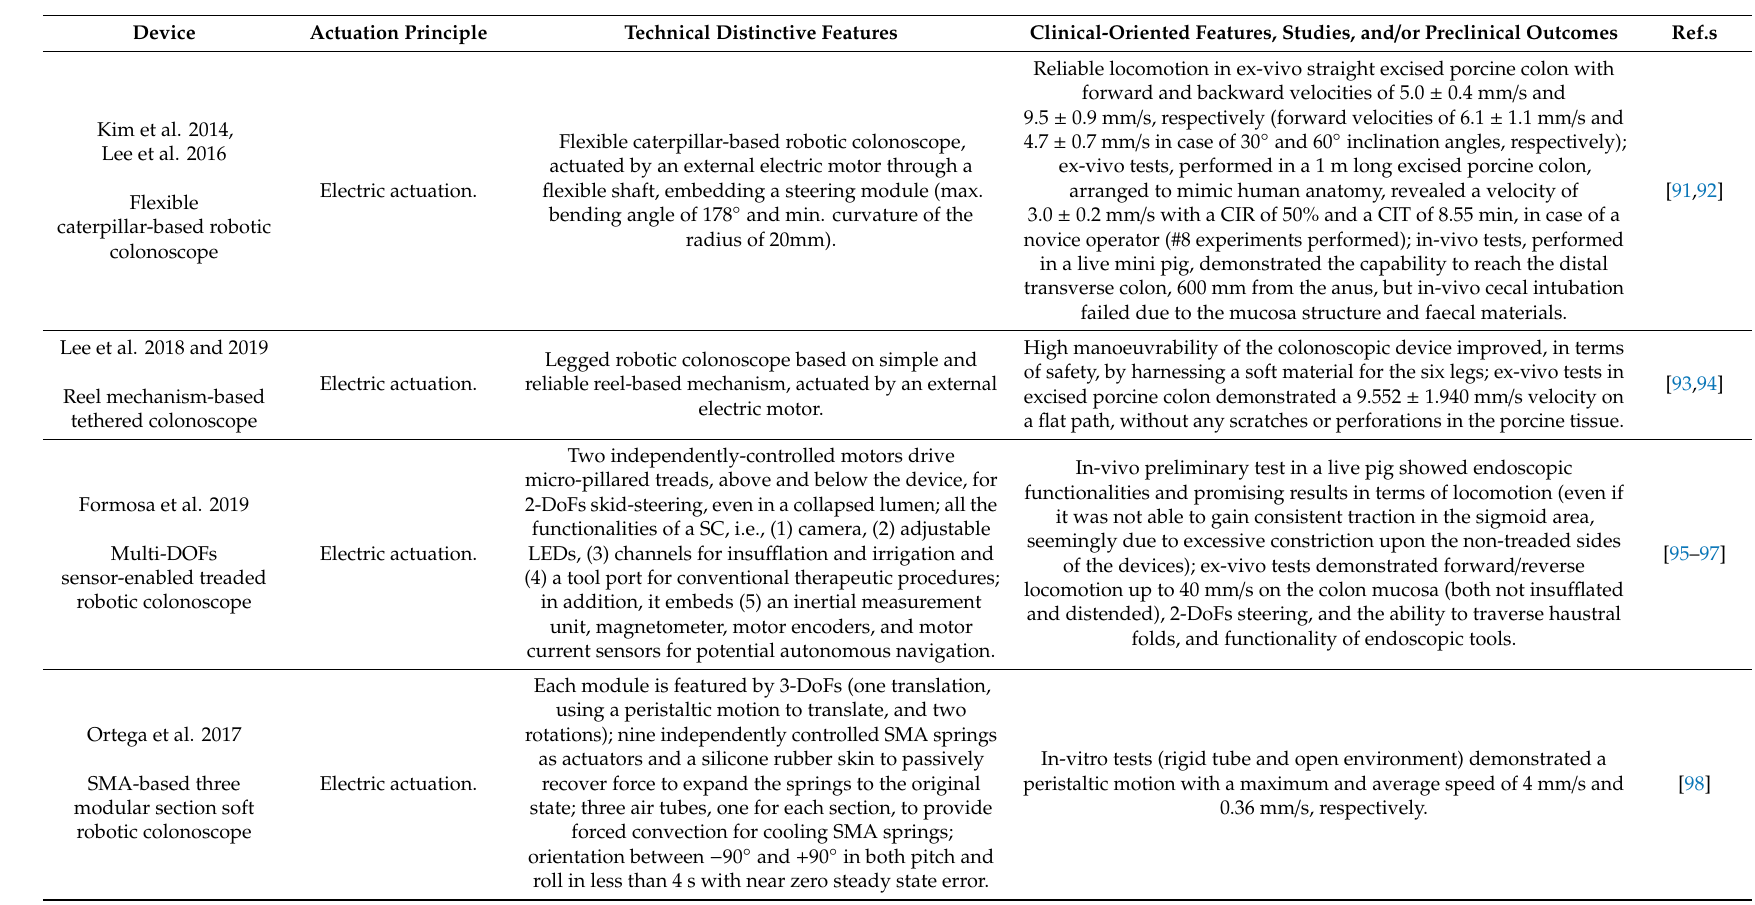
Table 3. Summary of the distinctive technical features and / or preclinical outcomes of innovative research-based robotic colonoscopes and